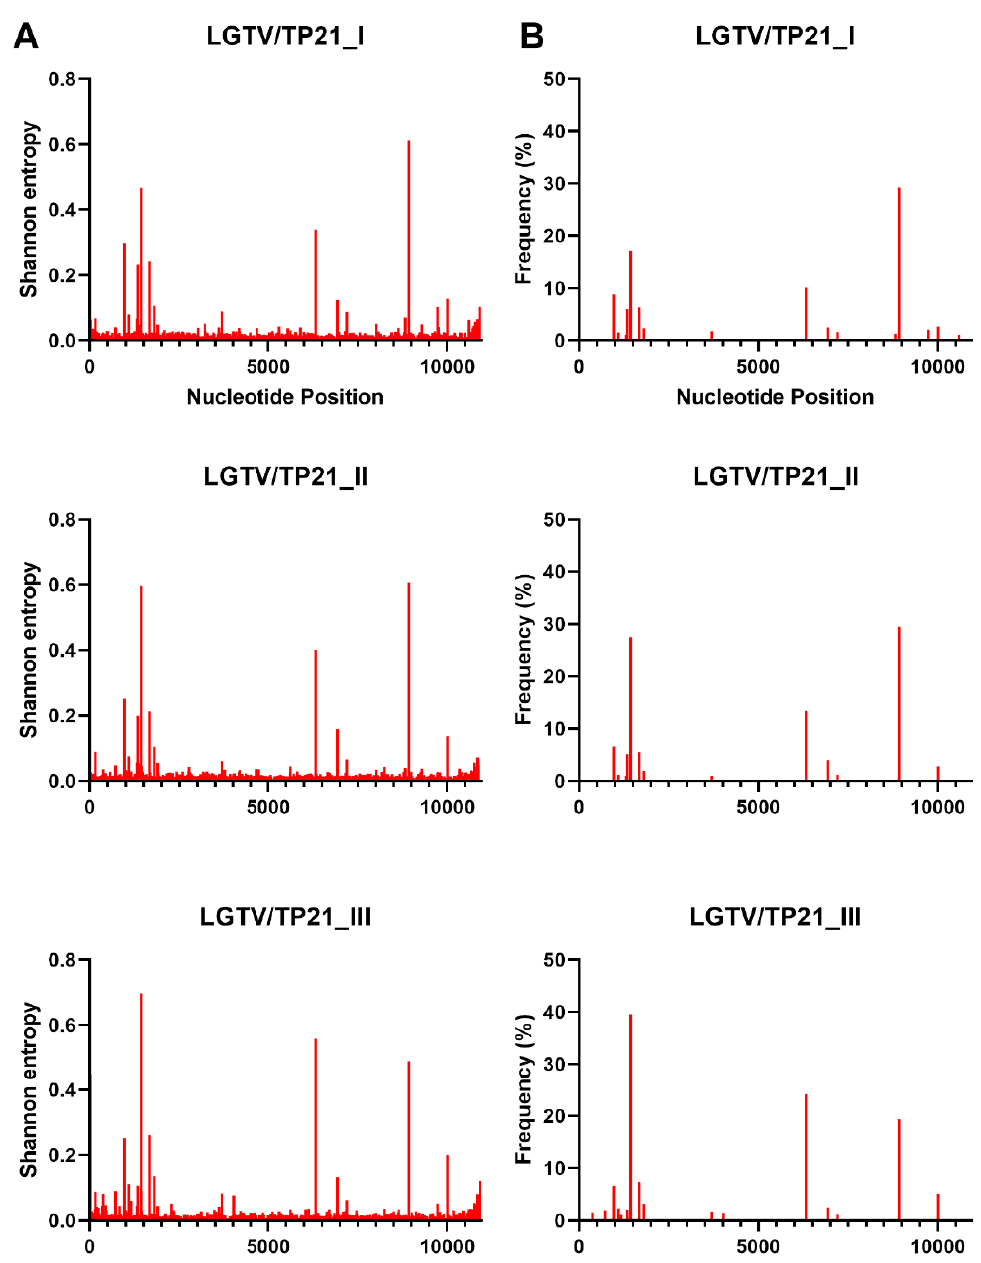
Figure 2. Shannon entropy ( A ) and SNVs ( B ) for each LGTV sample. See Table 1 for details of each sample and virus sample